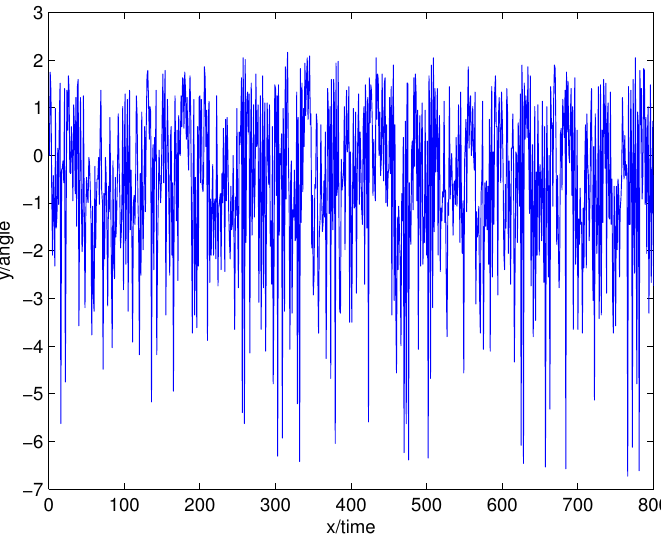
Figure 2. The original gyro